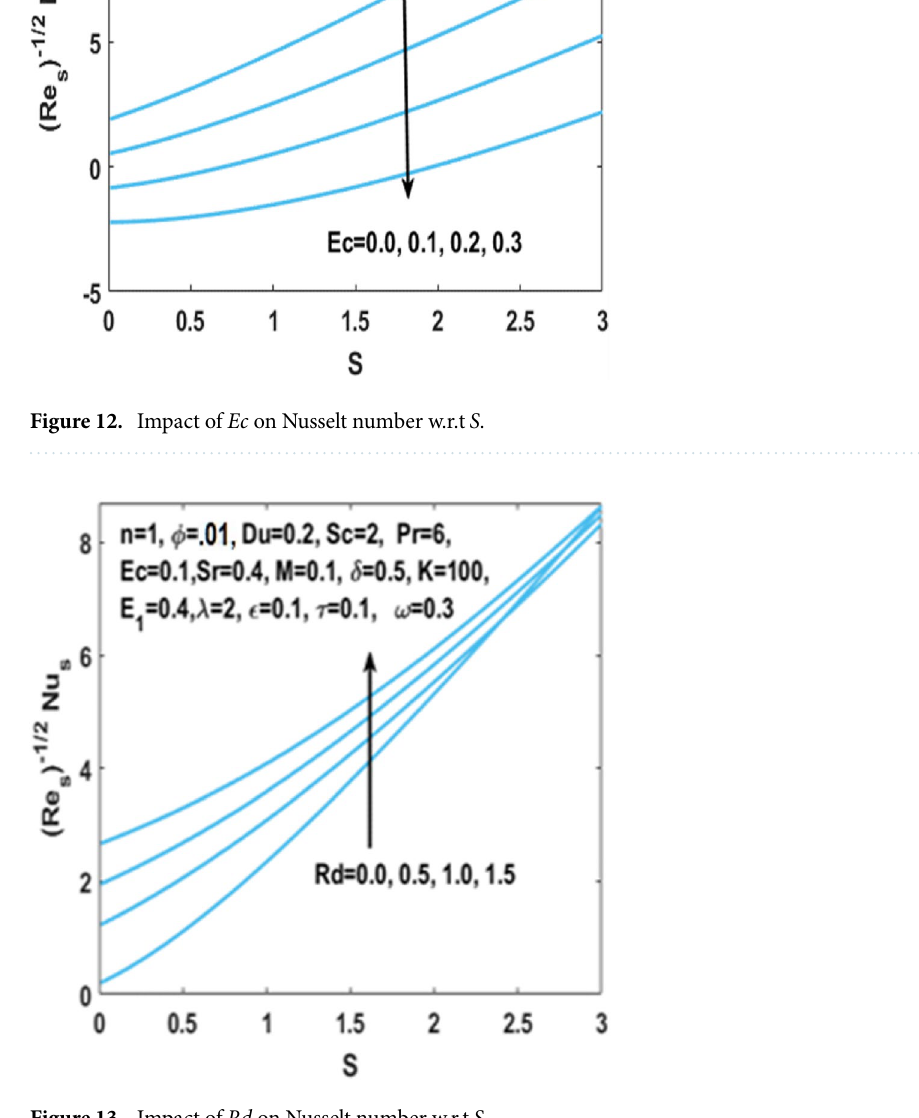
Figure 13. Impact of Rd on Nusselt number w.r.t S